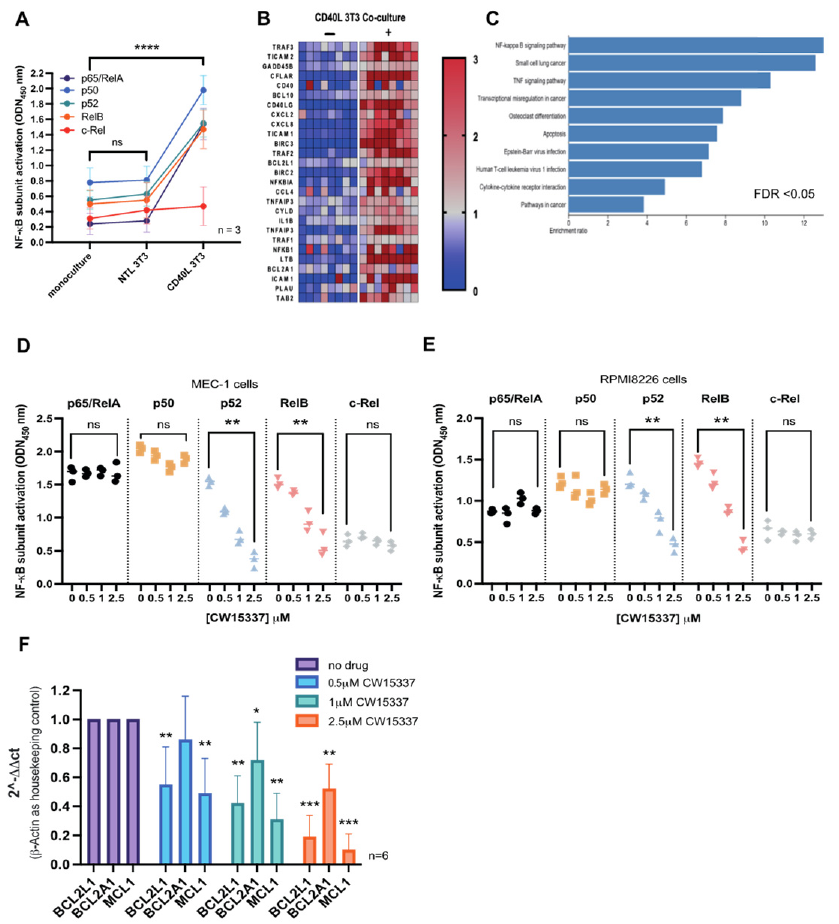
Figure 5. CW15377 preferentially inhibits the non-canonical NF- κ B pathway in tumor cells co- cultured on CD40L 3T3 cells. ( A ) Nuclear extracts were prepared from primary CLL cells following monoculture, co-culture on untransfected 3T3 cells and CD40L 3T3 cells. Extracts from CLL cells co-cultured on CD40L 3T3 cells showed a marked increase in both canonical and non-canonical subunit. ( B , C ) RNA sequencing showed a marked transcriptional activation of known NF- κ B-target genes. Furthermore, NF- κ B regulated genes were significantly overrepresented in the differentially expressed gene list. CD40L 3T3 co-culture of ( D ) MEC-1 cells and ( E ) RPMI8226 cells for 24 h with or without the addition of CW15337 for the last 8 h, showed that CW15337 preferentially inhibited the nuclear expression of p52 and RelB in a concentration-dependent manner. ( F ) QRT-PCR analysis of primary CLL cells ( n = 6) confirmed that the addition of CW15337 could repress the transcriptional activation of BCL2L1, MCL1 and to a lesser extent, BCL2A1 induced by CD40L 3T3 co-culture. FDR = false discovery rate. **** p < 0.0001, *** p < 0.001, ** p < 0.01 and * p < 0.05. ns = not